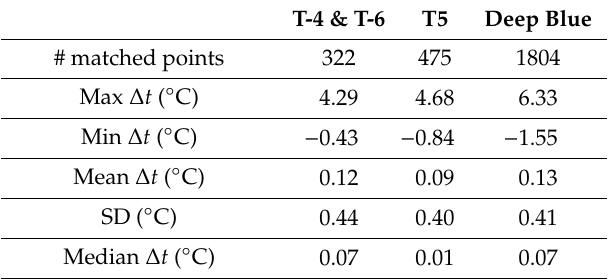
Figure 9. Box plot of temperature di ff erences (XBT-Argo). Mean values are indicated by empty squares. Table 5. ∆ t ( XBT-Argo) for each XBT type involved. Depth: 0 m-bottom ( ± 1 day).